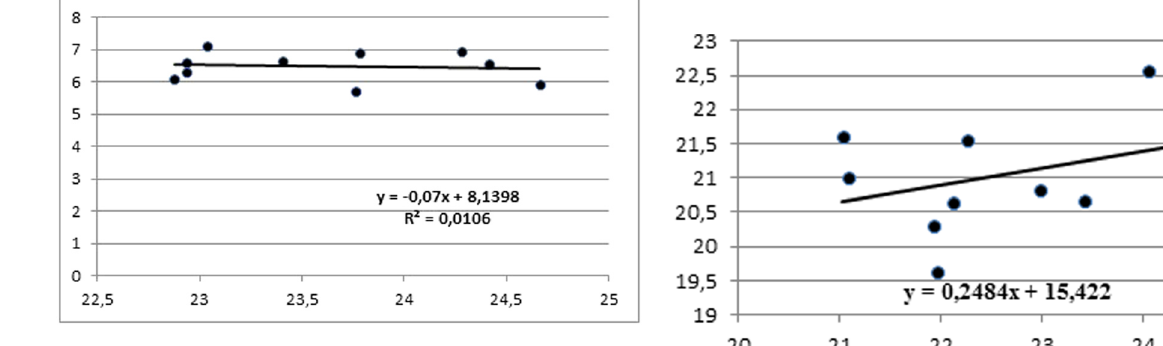
Figure 7: Linear approximation of the dependence of meat content on fat content in the pelvic - femoral third of the carcass at a slaughter weight of 110 kg.